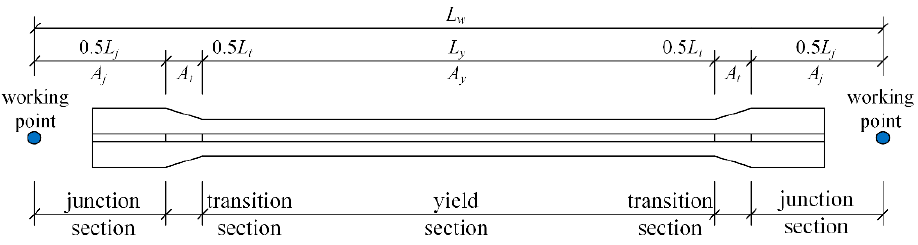
Figure 8. Sketch diagram of buckling-restrained brace.